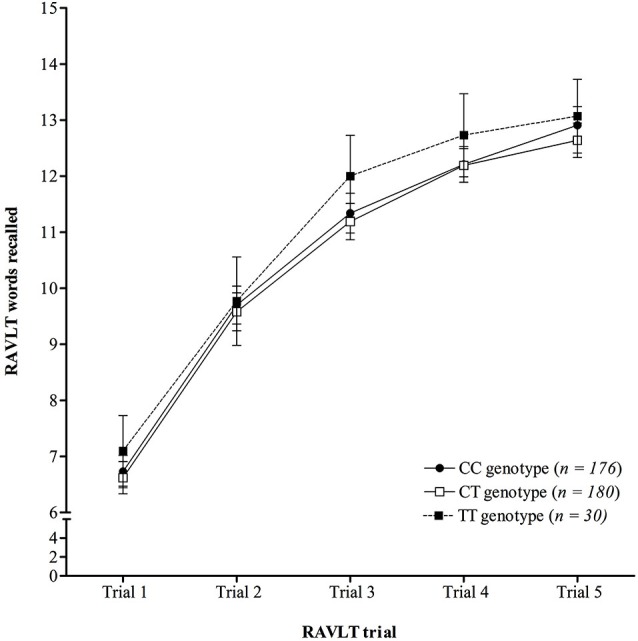
Mean number of words recalled on each trial of the RAVLT across KIBRA genotype, showing no significant interaction. Error bars display 95% confidence intervals.